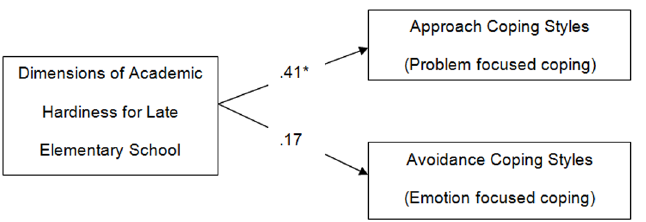
Figure 1. Correlations between the “Dimensions of Academic Hardiness Questionnaire” for late elementary school children and coping styles (approach and avoidance). * p < .05.